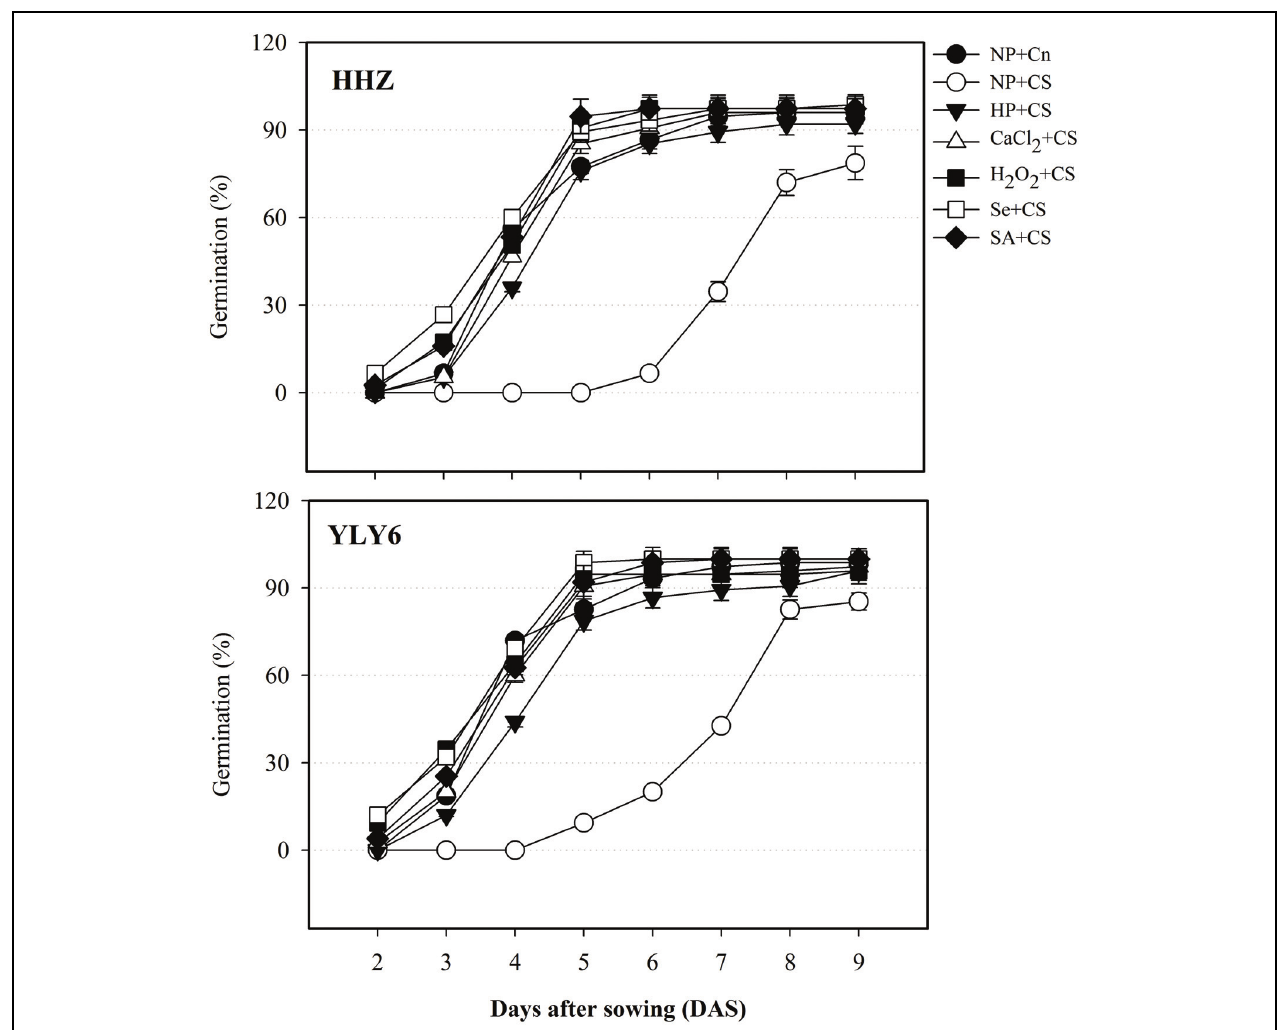
FIGURE 1 | Influence of various seed priming treatments on germination dynamics of two rice cultivars under chilling stress. Vertical bars above mean indicate standard error of six replicates. NP + Cn: no priming and no stress, NP + CS: no priming and chilling stress, HP + CS: hydropriming and chilling stress, CaCl 2 + CS: calcium chloride priming and chilling stress, H 2 O 2 + CS: hydrogen peroxide priming and chilling stress. Se + CS: selenium priming and chilling stress, and SA + CS: salicylic acid priming and chilling stress, Cn: 28 ◦ C, CS: 18 ◦ C, HHZ: inbred cultivar huanghuazhan, YLY6: hybrid variety